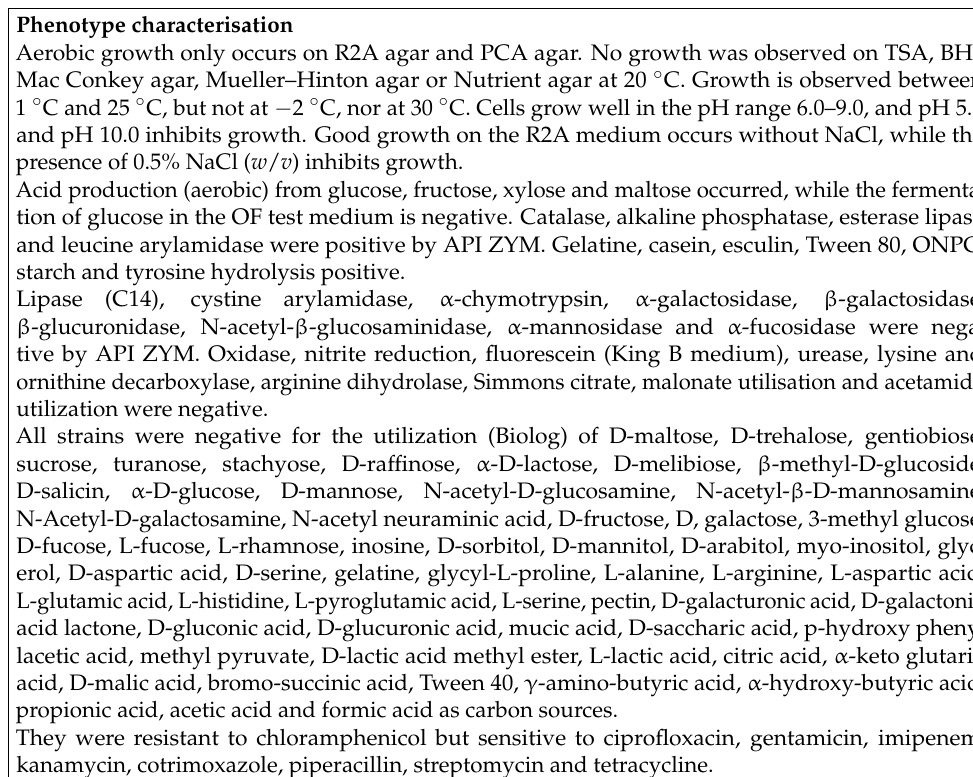
strain, Table S3: Phage DNA within the P8398 T genome, Table S4: R-M systems in the P8398 T genome, Table S5: Cellular fatty acid contents of Massilia antarctica sp. nov. strains and the closest phylogenetic relatives, Table S6: Variable reactions of Massilia antarctica sp. nov.